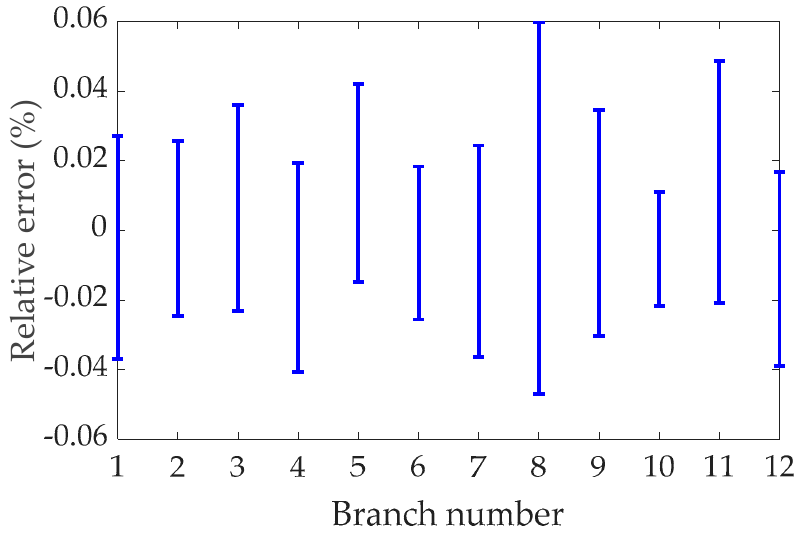
Figure 6. The relative error between the calculation result of the forward dynamic equations (FDEs) and the simulation result of ADAMS.